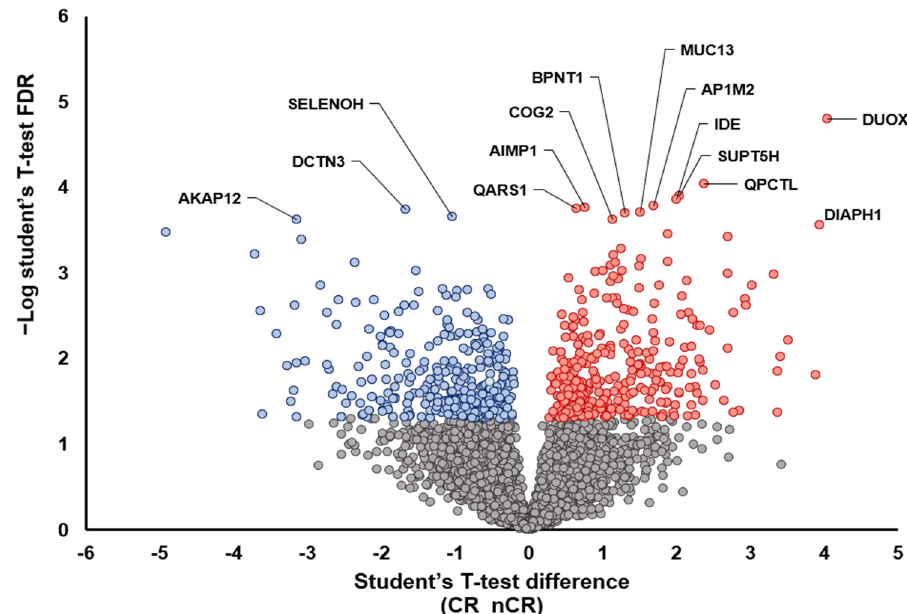
Figure 2. Volcano plot depicting the variance inexpression between CR and nCR groups. Highlighted data points indicate the key proteins that show the most significantly discriminative power (blue dots, increased intensity in CR group; red dots, increased intensity in nCR group).